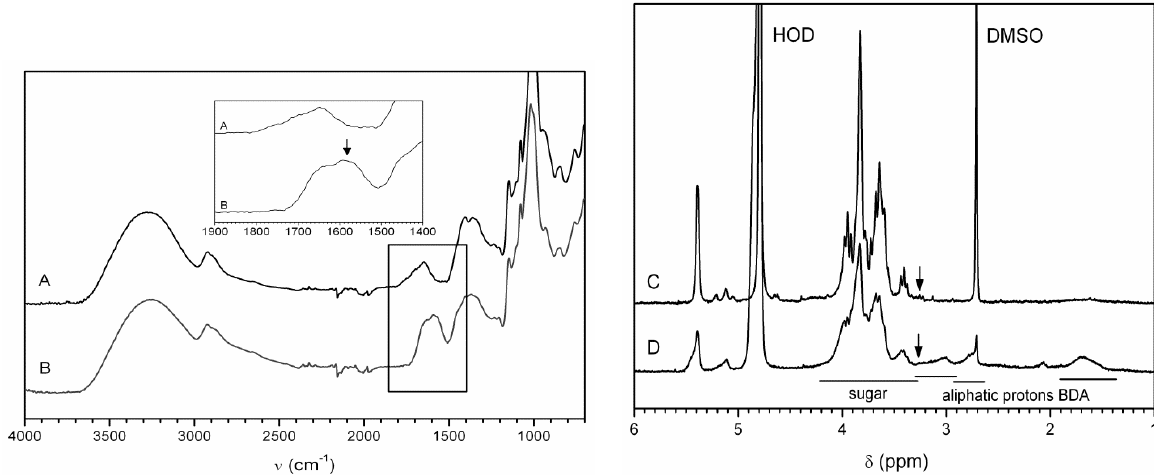
Figure 6. ( Left ) ATR-FTIR spectra of ( A ) butane diamine (BDA)-(G7)